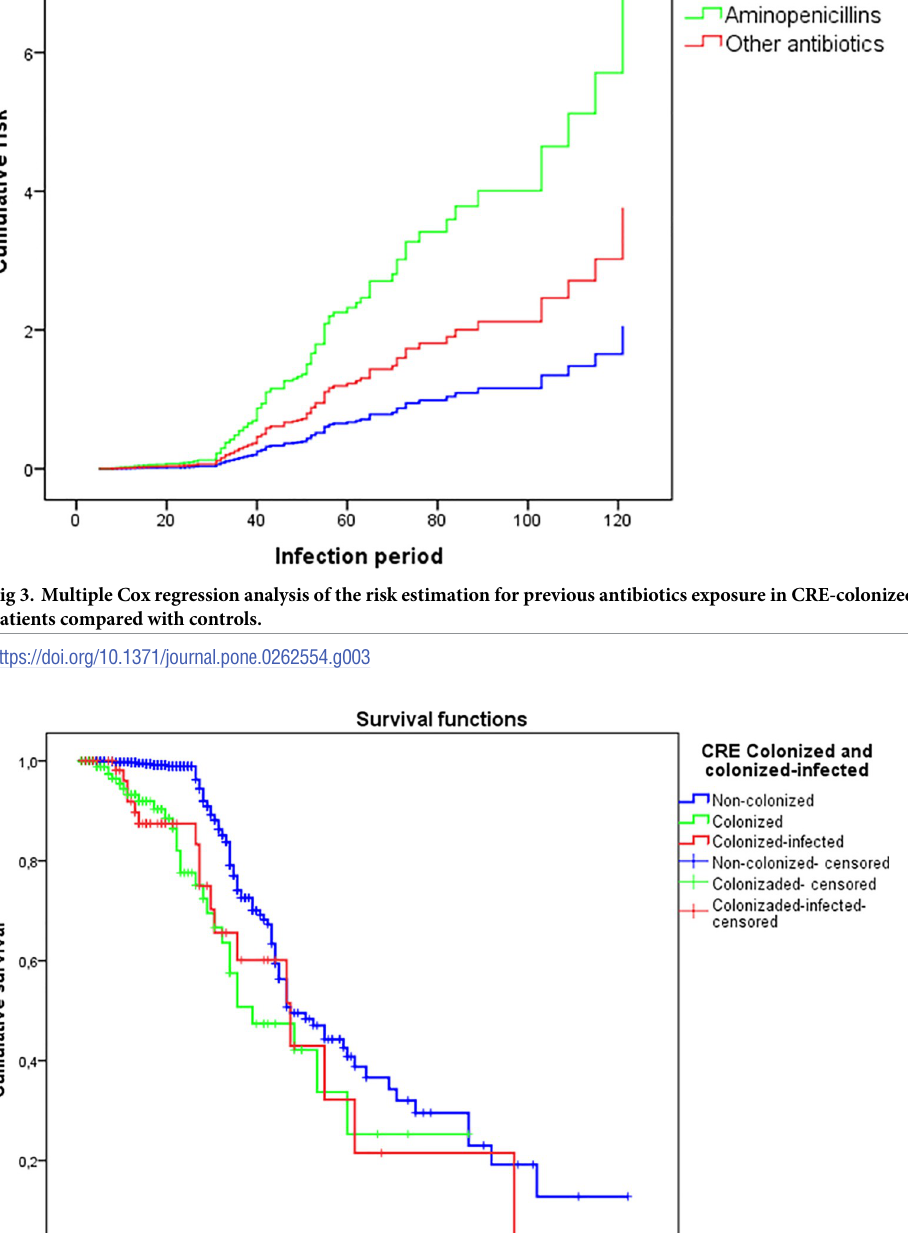
PLOS ONE | https://doi.org/10.1371/journal.pone.0262554 January 20,